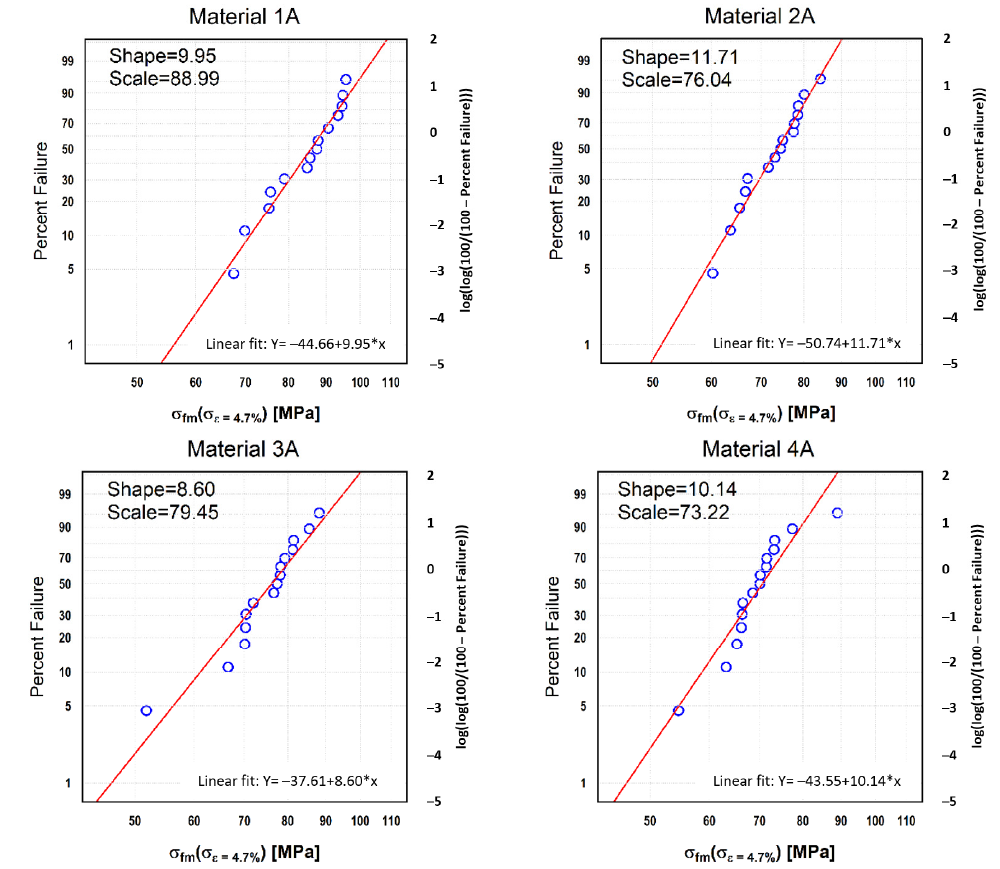
Figure 8. Weibull’s grids describing the flexural strength.